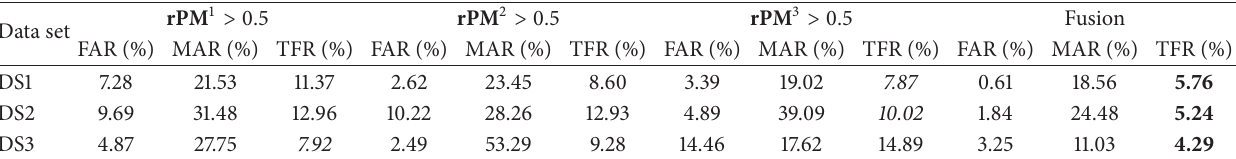
Table 2: Performance evaluation of the monoscale and the multiscale results. The bold value is the best and the italic one is the second. Data